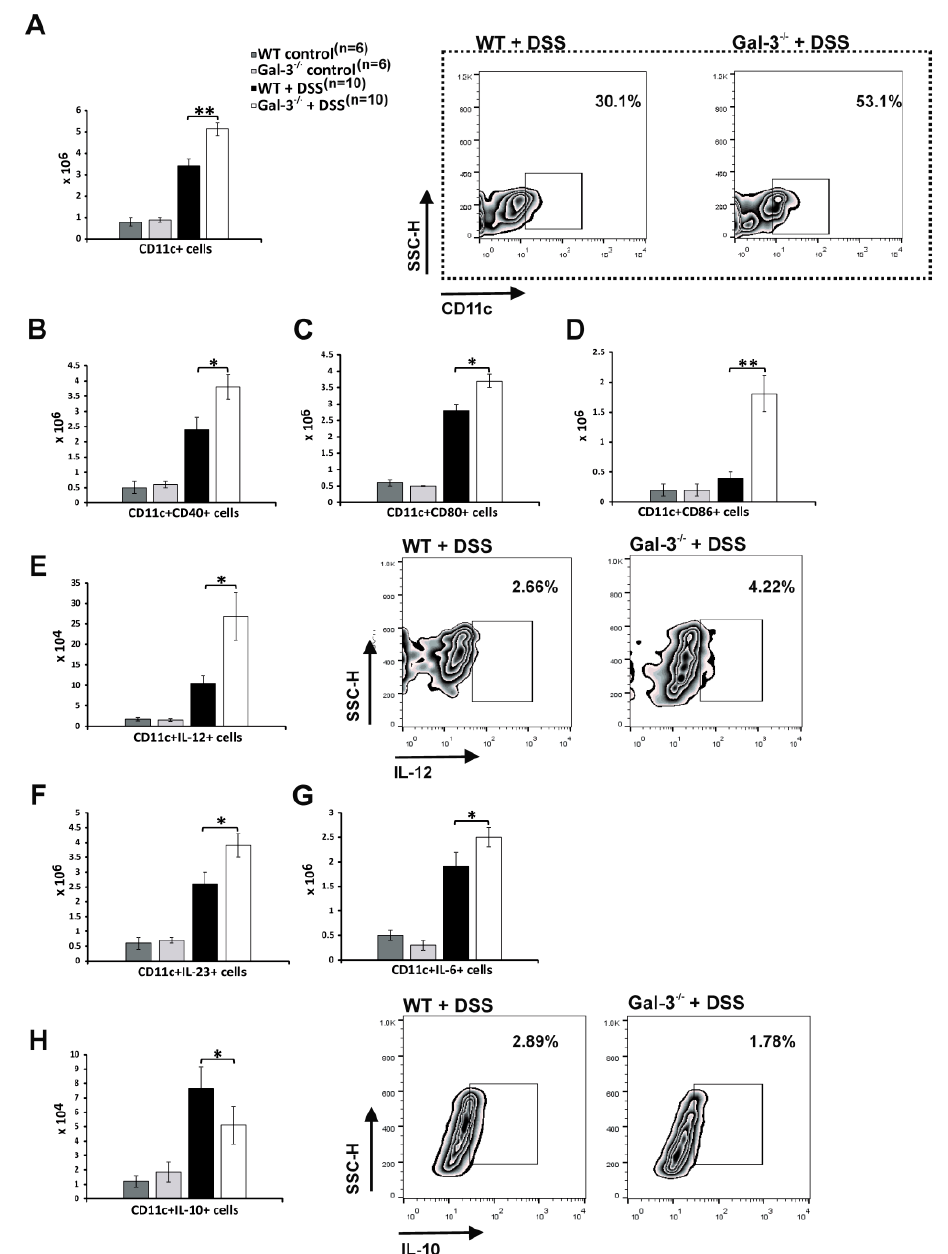
Figure 4. Gal-3 deletion favored development of inflammatory phenotype in colon-infiltrated DCs. The total number of CD11c + DCs in colons of DSS-treated WT and Gal-3 − / − mice 28 days after initial